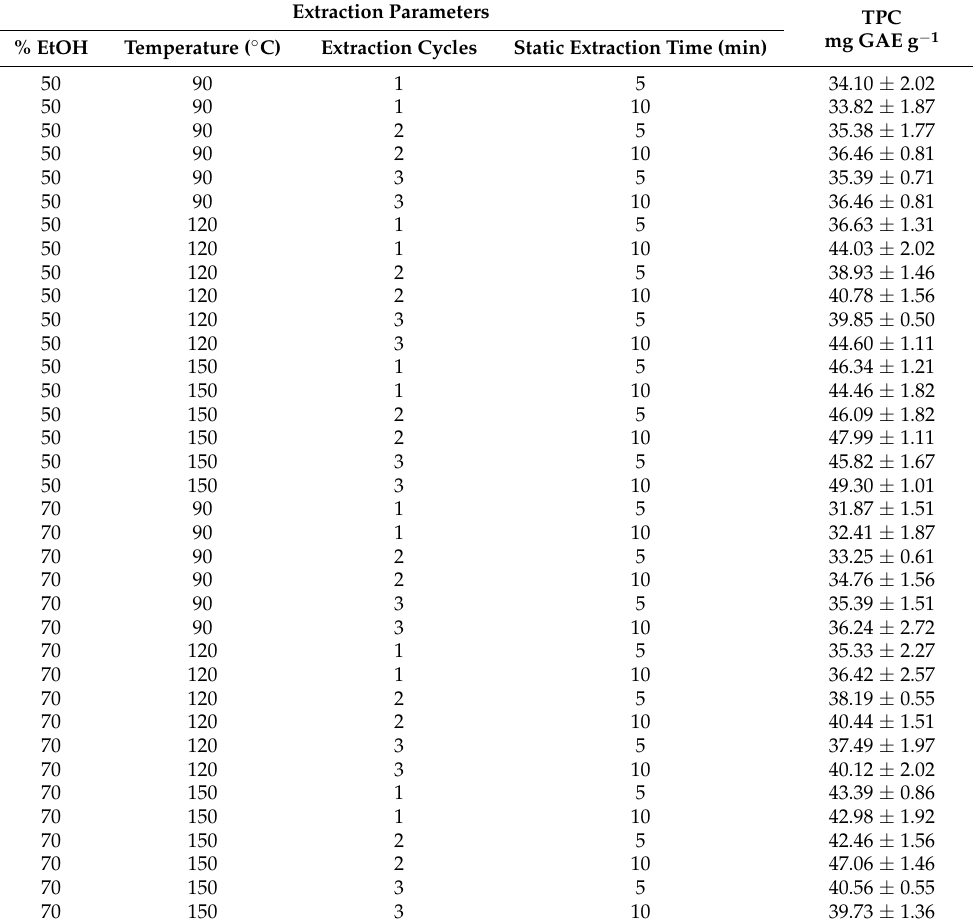
Table 1. Total phenolic content of laurel leaf extracts obtained by PLE.